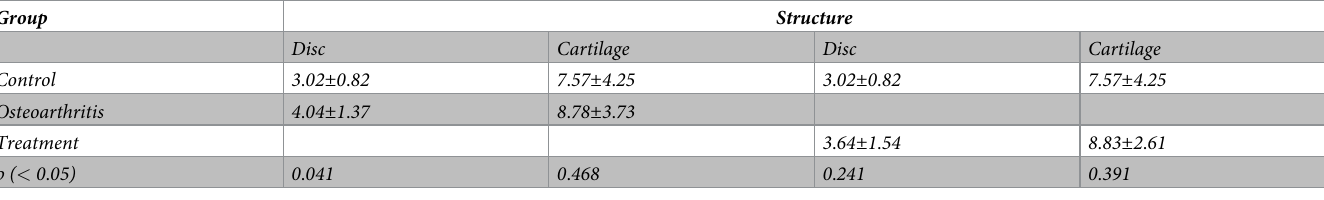
Table 1. Concentration of glycosaminoglycans in control vs osteoarthritis groups and control vs treatment groups.